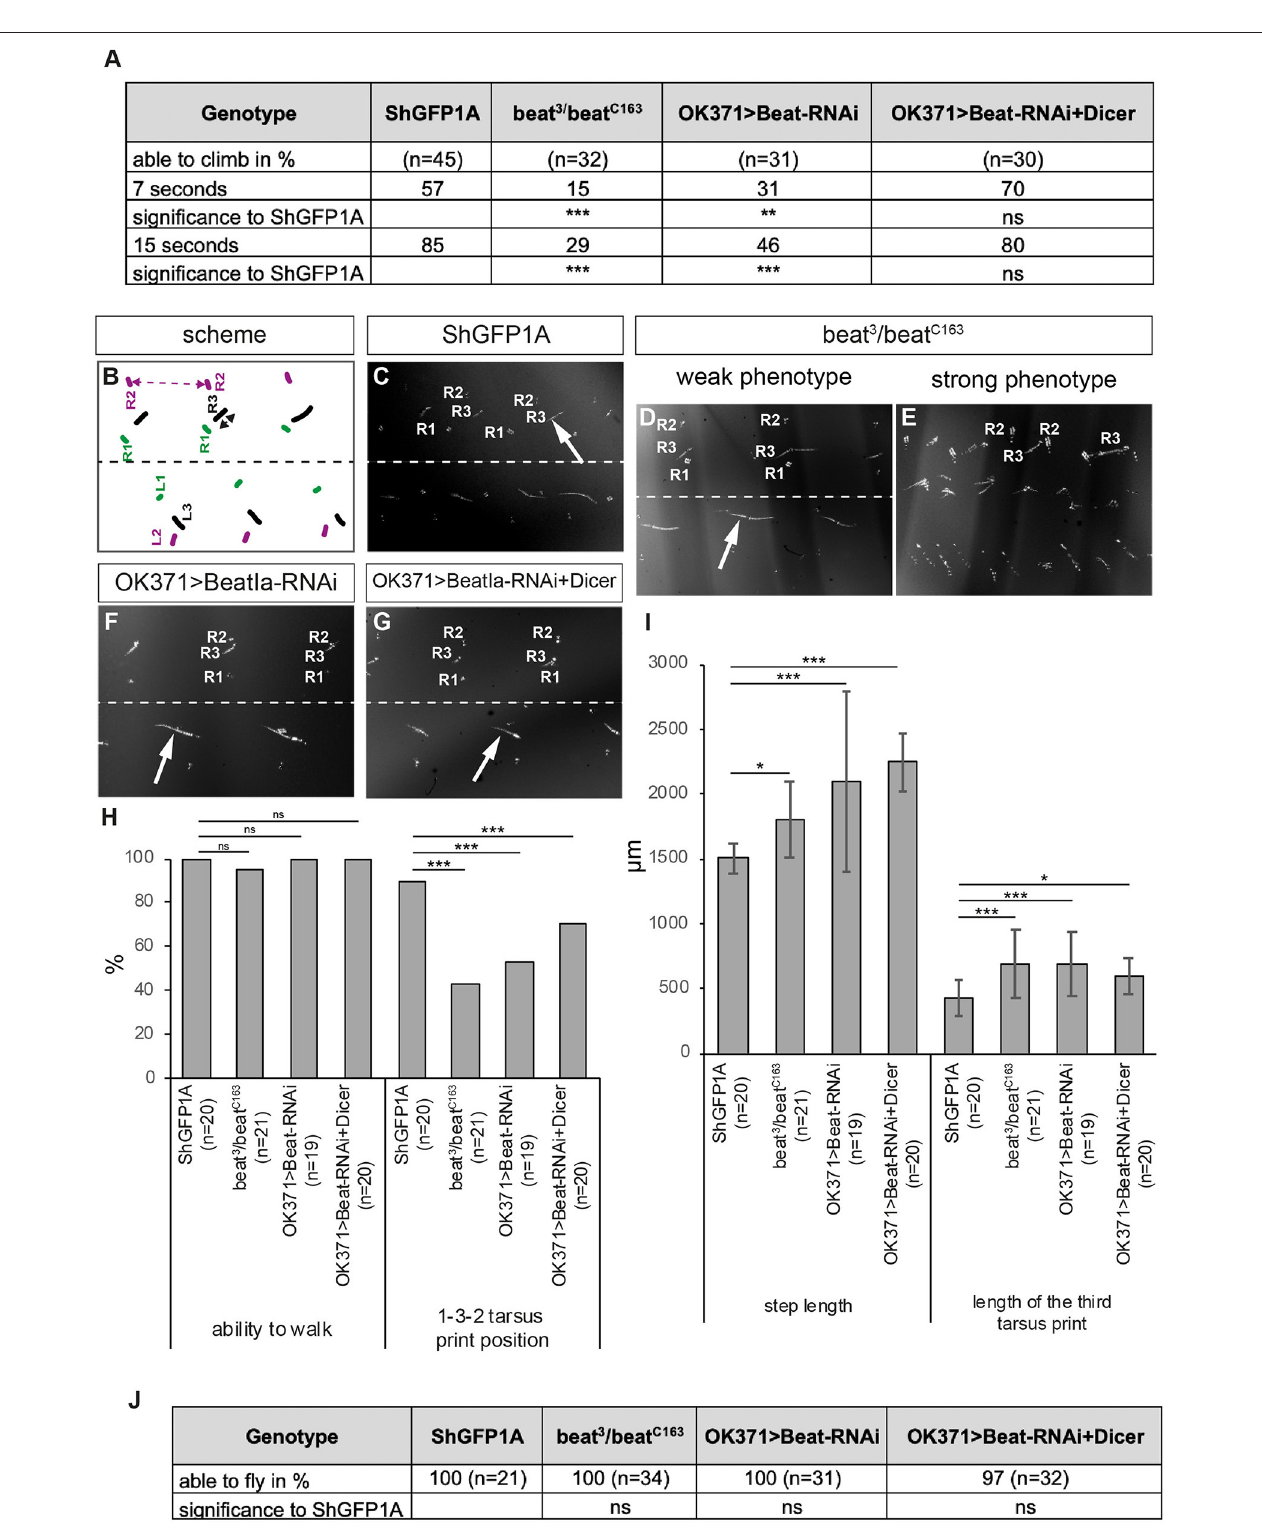
FIGURE 7 | Loss of Beat alters walking behaviour. (A) Percentage of flies of the indicated genotypes that are able to climb in an empty vial. Loss and downregulation of Beat results in a decreased number of flies capable of climbing compared to controls. However, further enhancement using Dicer had no effect. (B) Scheme of